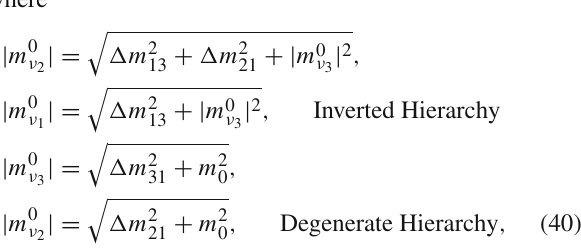
Fig. 1 From left to right: the atmospheric angle versus a the reactor angle, b | m 0 ν and green points stand for